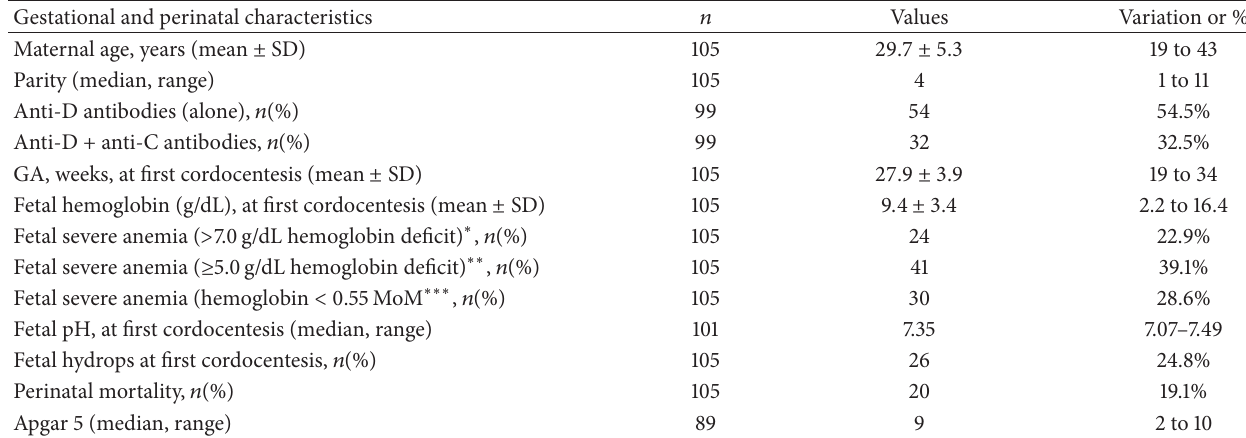
Table 1: Characteristics of alloimmunized pregnancies included in the study.